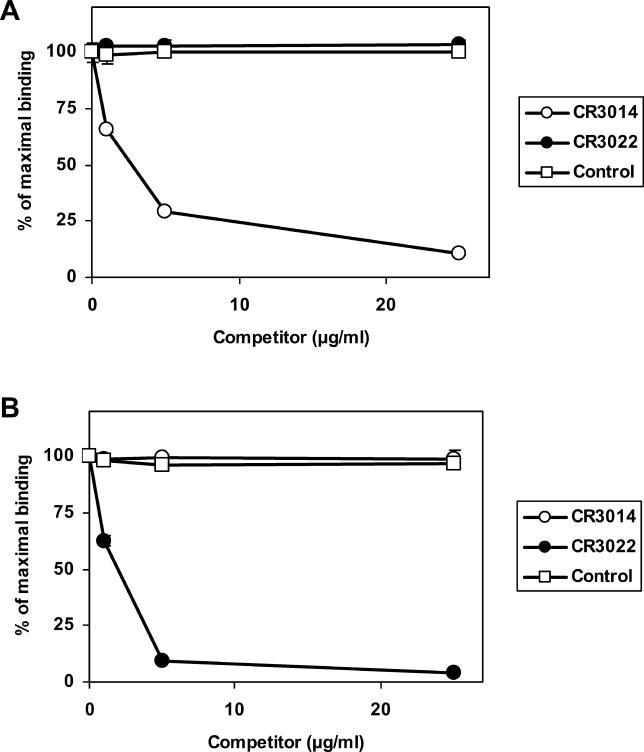
Competition ELISA on Immobilized S318–510Binding of biotinylated CR3014 (A) and CR3022 (B) was analyzed in the presence of competitor CR3014 (open circles), CR3022 (closed circles), and control mAb (open squares). Binding is expressed as percentage of binding without competitor.